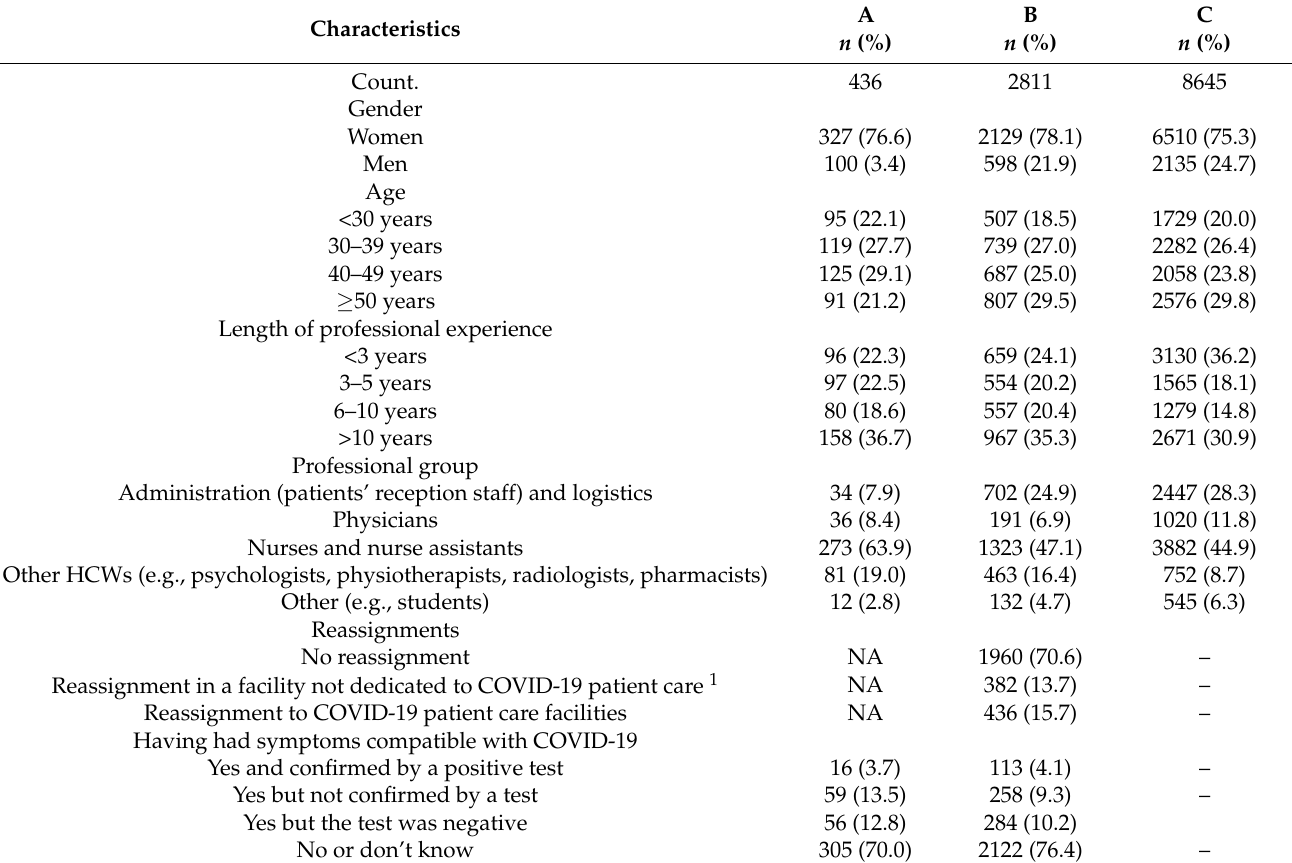
Table 1. Characteristics of the reassigned respondents (study sample A), all survey respondents (B), and eligible health care workers (HCWs)